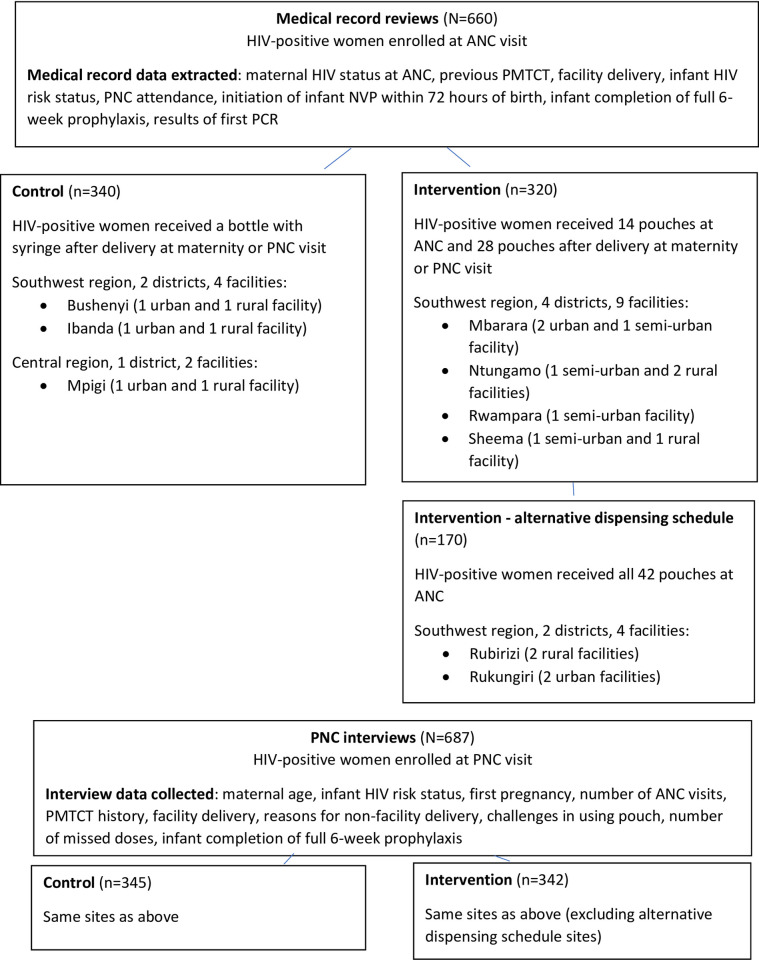
Study enrollment.